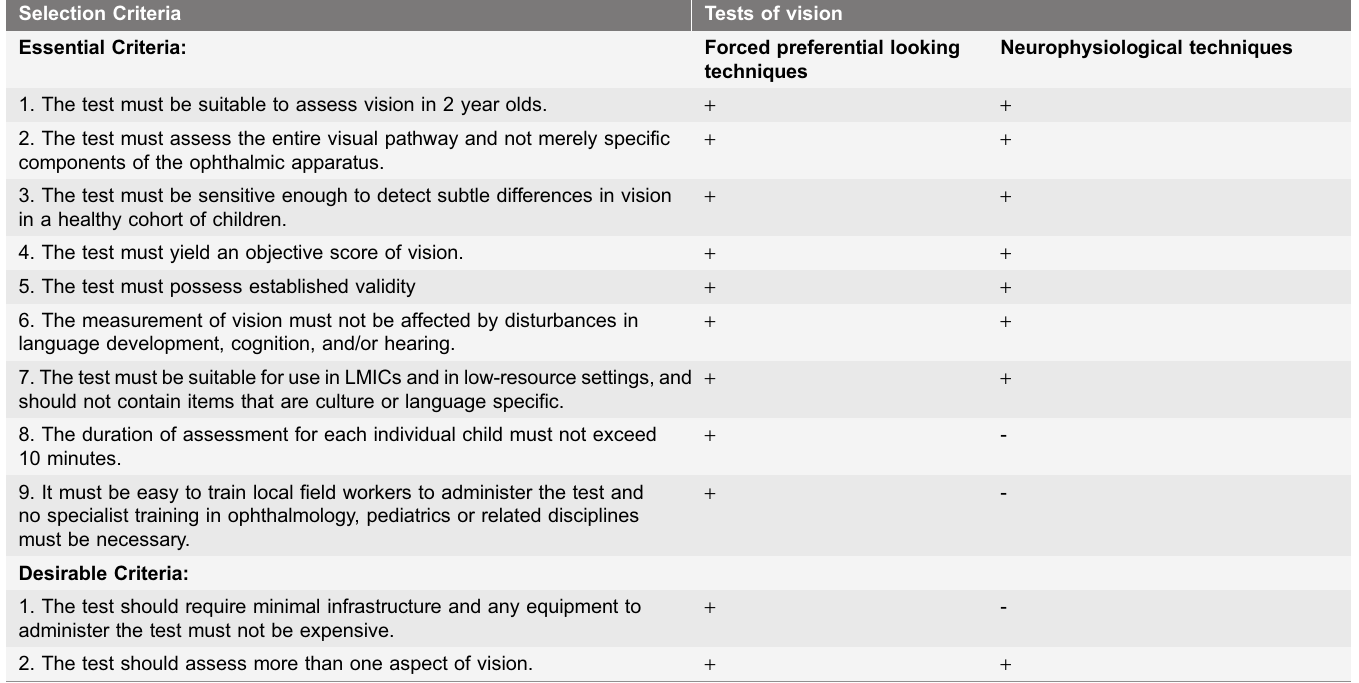
Table 6. Analysis of candidate vision tests against selection criteria. Selection